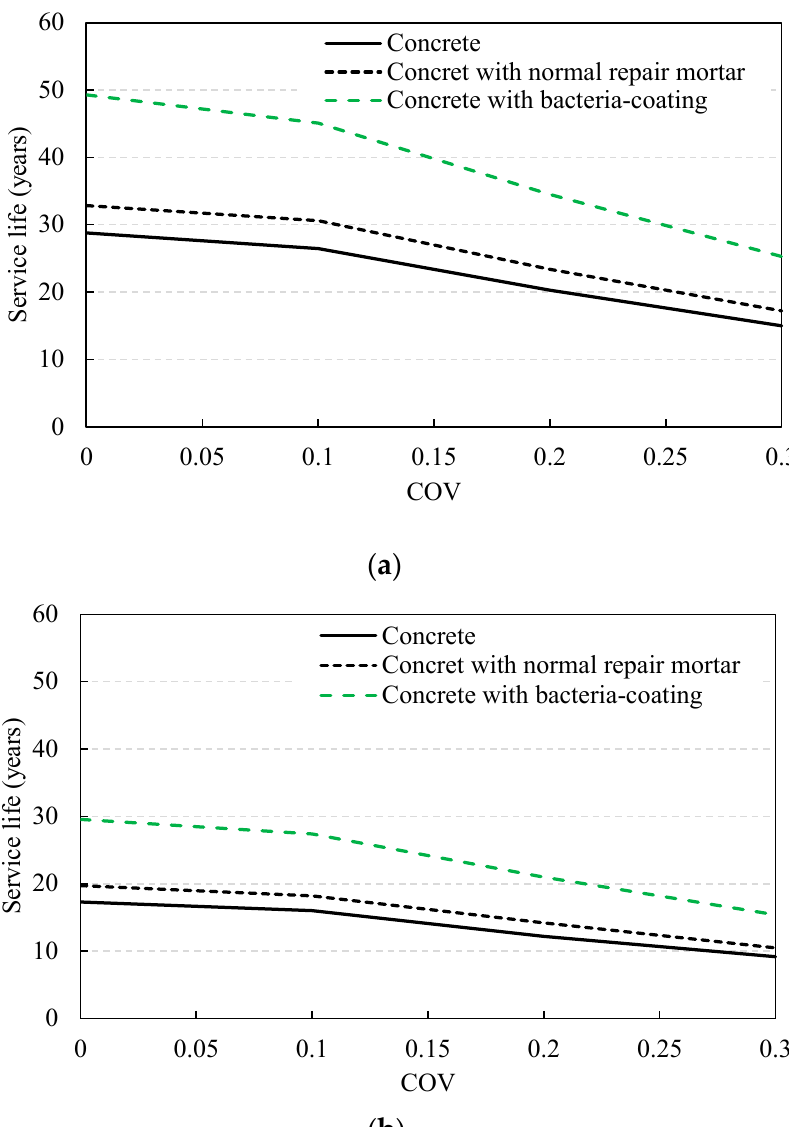
Figure 15. Service life variation with increasing COV according to probabilistic method: ( a ) sulfate concentration = 120 ppm; ( b ) sulfate concentration = 200 ppm.